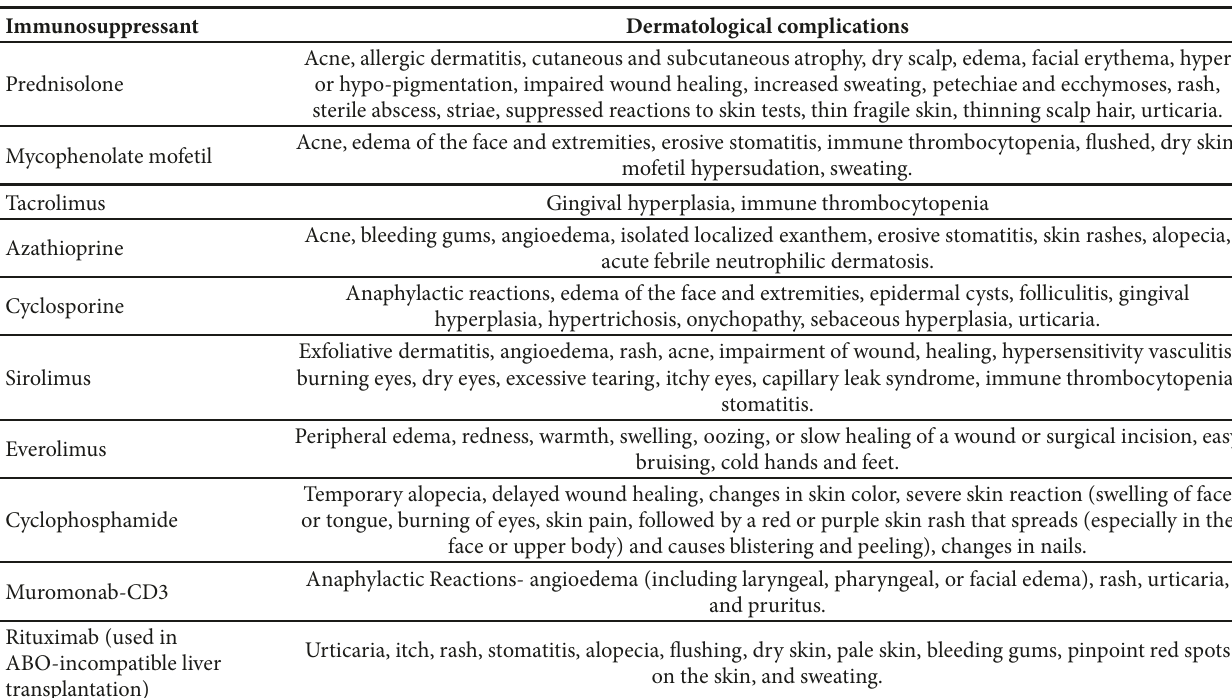
Table 2: Dermatological complications due to immunosuppressant